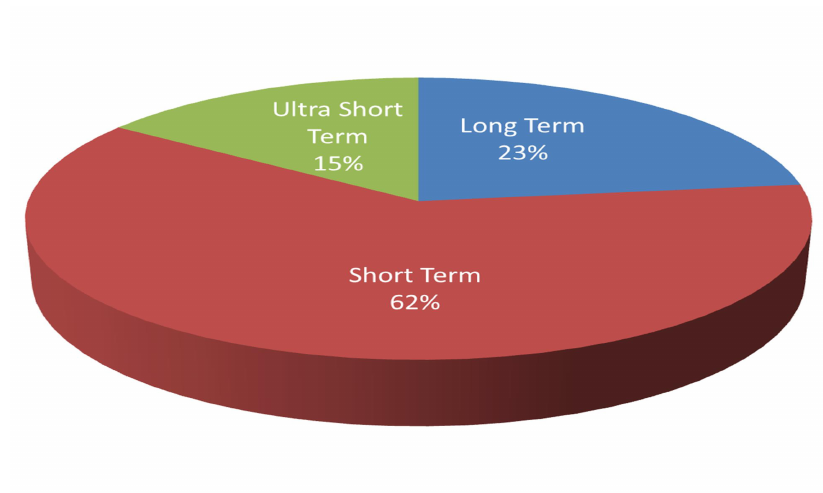
Figure 1. The distribution of articles reviewed into long-term, short-term and ultra-short-term predictions.